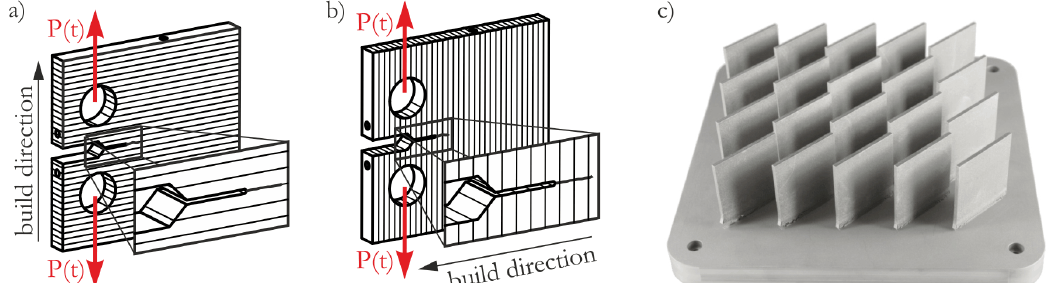
Figure 3: Orientation of build and initial crack direction. Depending on the machining of samples from the plates shown in c) specimens with crack plane normal a) and parallel b) to the build direction were